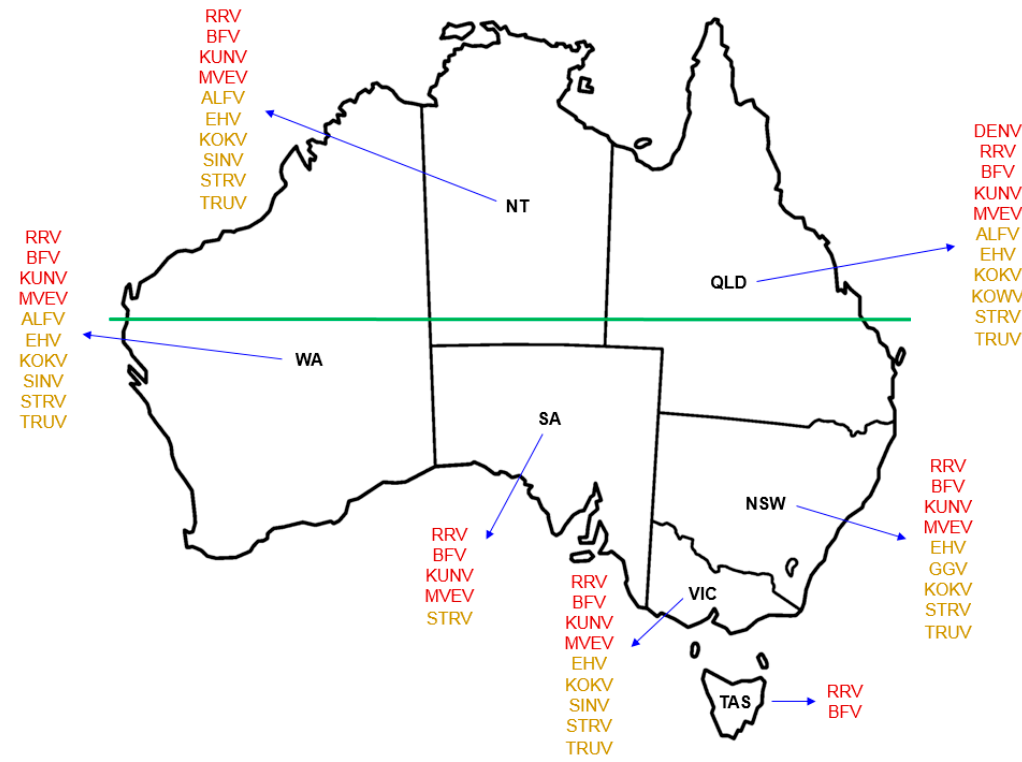
Figure 1. Geographical distribution of Australian indigenous arboviruses known to cause human infection. Use of red font for each named virus indicates the state or territory from which that virus is known to be recovered and the notifiable disease for which it is listed in the Australian National Notifiable Disease Surveillance System (ANNDSS). Use of amber font for each named virus indicates the reported recovery of that virus from mosquitoes during mosquito surveillance but that the corresponding virus-associated disease is not currently recorded in the ANNDSS. Named